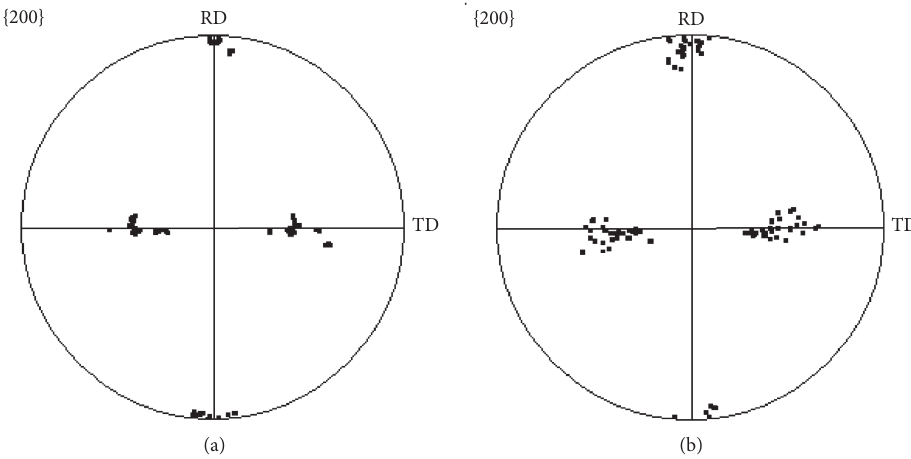
Figure 5: The texture of the center and edge seam areas in the core plane of SSS. (a) Central region. (b) Edge seam